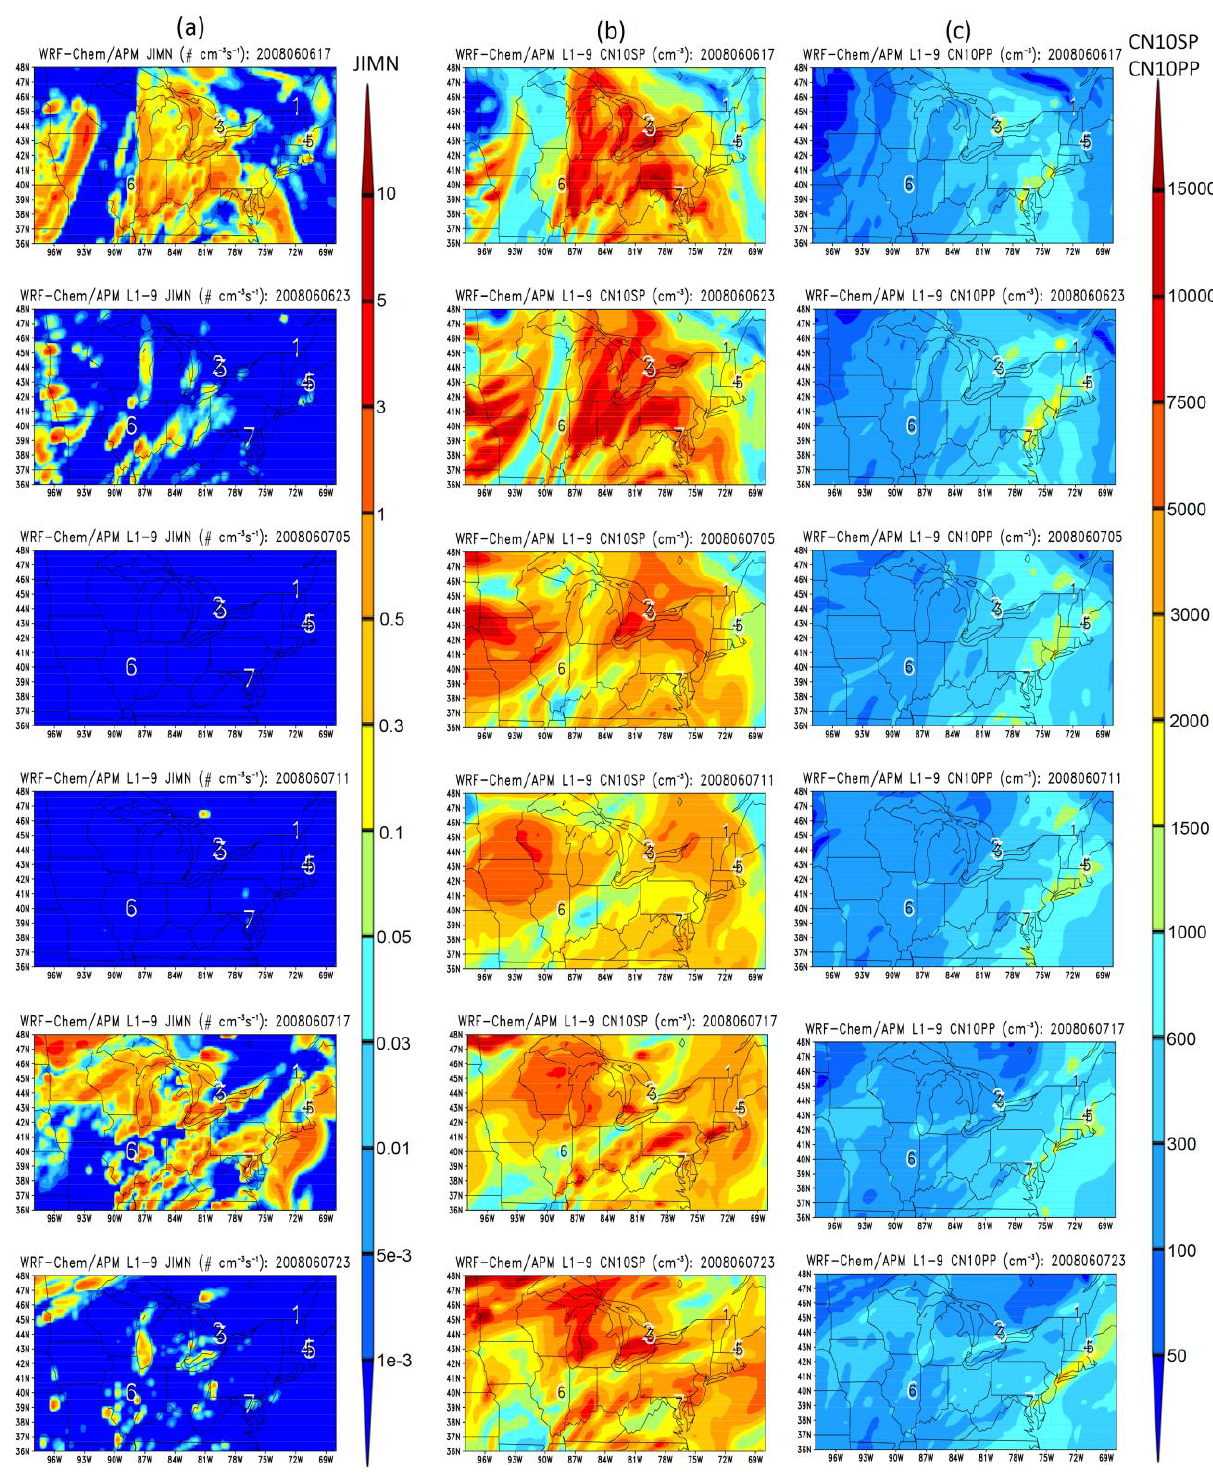
Fig. 9. Simulated (a) ion-mediated nucleation rate (JIMN) and number concentrations of (b) secondary and (c) primary particles larger than Figure 9 . 10nm (CN10SP, CN10PP) in the northeast US, averaged within the first two km above the surface (model layer 1–9) during a two day period (6–7 June). Number 1–7 overlayed on each panel mark the locations of seven AERONET sites given in Fig.